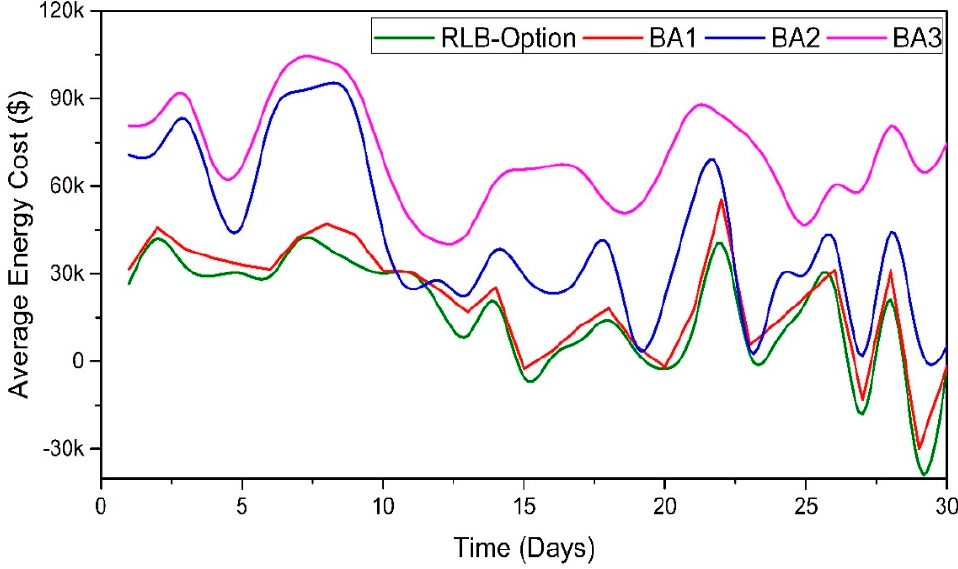
Figure 4. Average daily energy cost of RLB-Option and baseline algorithms.